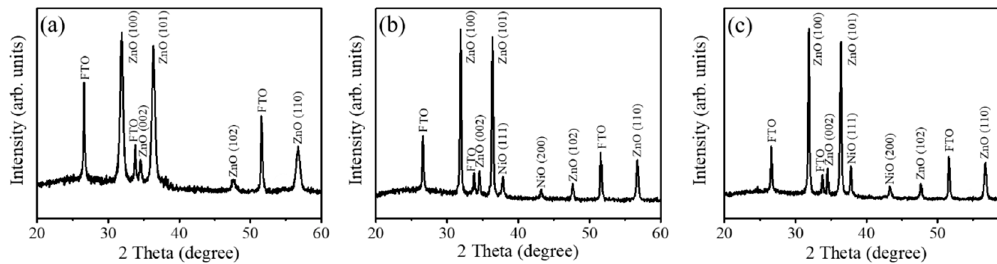
Figure 2. ( a ) XRD pattern of the pristine porous ZnO nanosheets. The XRD patterns of the porous ZnO-NiO composite nanosheets: ( b ) ZnO-NiO-1 and ( c ) ZnO-NiO-2.